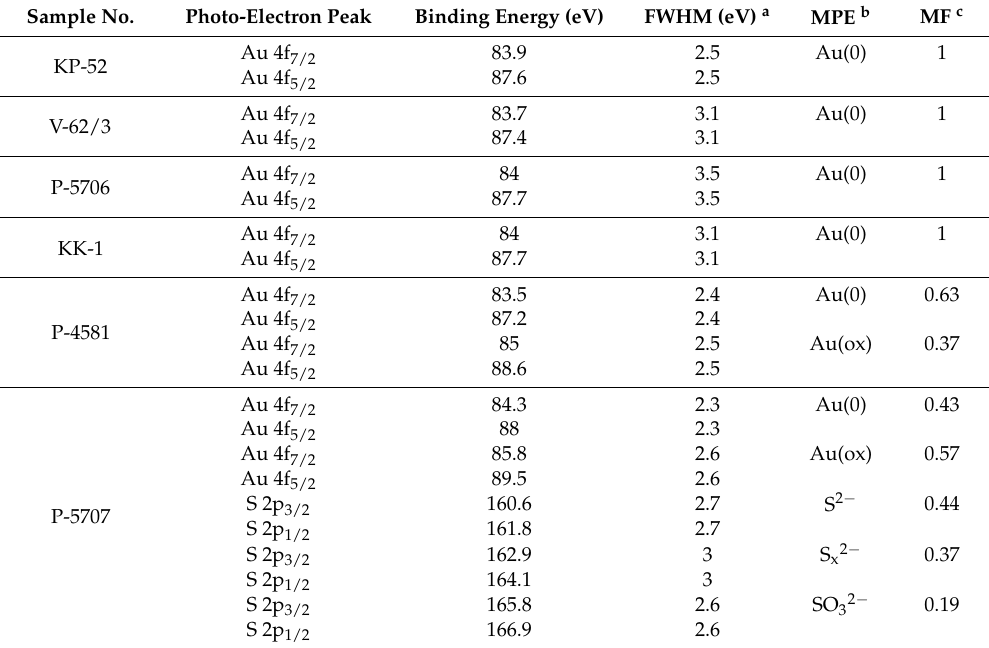
Table 2. XPS data of native gold samples